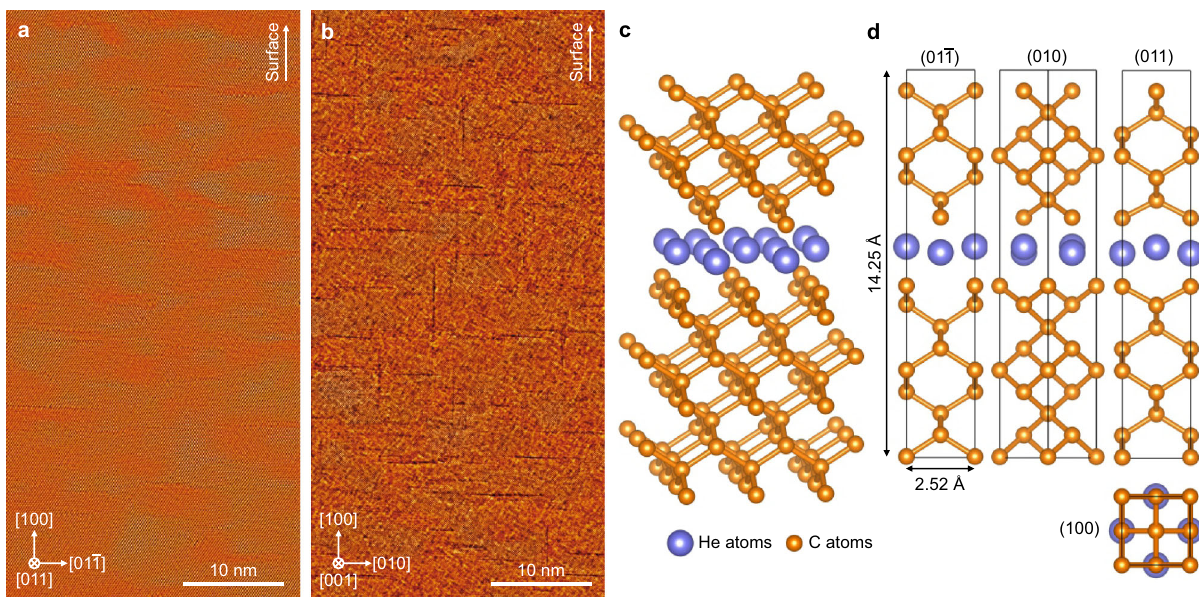
Fig.2|Heliumplateletsindiamond. Large- fi eld-of-viewiDPCSTEMimagesunder the a [011] and b [001] zone axes illustrate helium platelets in diamond. c Atomic structural model of {100} two-dimensional solid helium con fi ned by the diamond